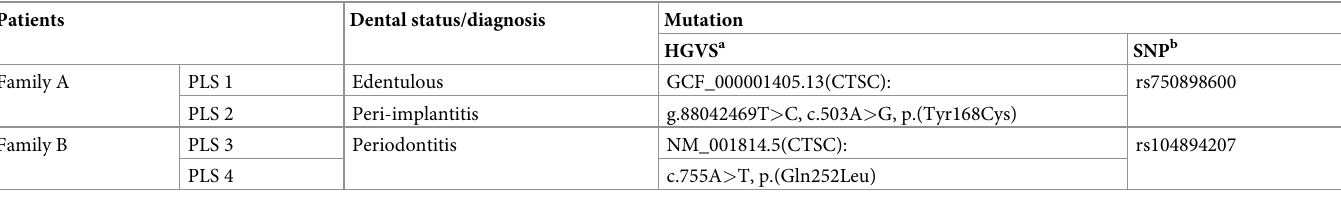
Table 2. Overview of the PLS